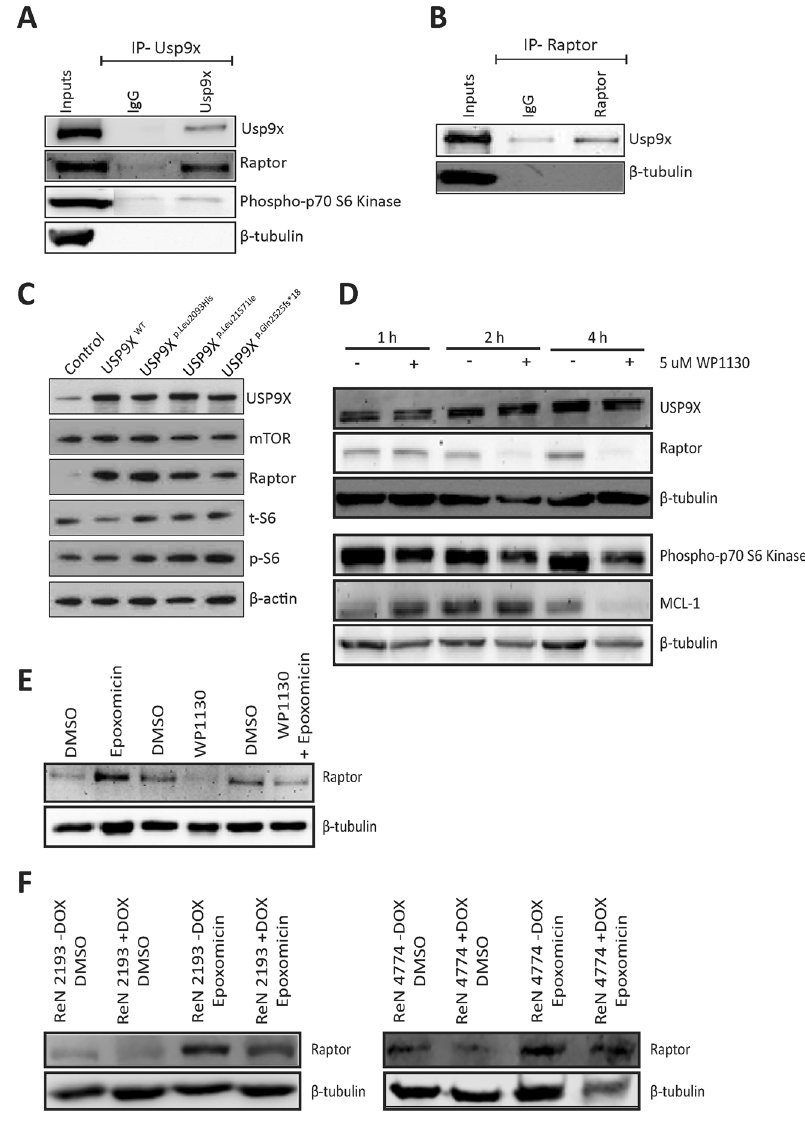
Figure 4. USP9X regulates RAPTOR levels and opposes its proteasomal degradation in neural progenitors. ( A , B ) Co-immunoprecipitation of endogenous Usp9x and Raptor from E14.5 mouse frontal cortex. ( A ) Anti- Usp9x antibodies precipitated Raptor protein. An interaction with pp70S6 kinase was also detected. ( B ) Anti- Raptor antibodies precipitated Usp9x protein. ( C ) USP9X over-expression increased RAPTOR protein levels. Proliferating HEK293T cells were transiently transfected with empty vector, full length USP9X (WT) or one of three USP9X variants, which do not affect enzymatic activity but are associated with human intellectual disability. Cell lysates were collected 24 hours later. Immunoblot analysis identified increased RAPTOR protein but mTOR and total S6 levels were unaffected. ( D ) Chemical inhibition of USP9X deubiquitylating activity leads to a rapid depletion of RAPTOR protein in neural progenitors. ReNcell VM cells were treated with 5 μ M WP1130 and analysed by immunoblot. WP1130 does not deplete USP9X protein levels over 4 hours but results in almost complete loss of RAPTOR by 2 hours. pp70S6 kinase levels were not affected. Levels of another USP9X substrate MCL1 were depleted after 4 hours. ( E ) RAPTOR protein levels are regulated by proteasomal inhibition (epoxomicin) and inactivation of USP9X deubiquiytlating activity (WP1130) in ReNcell VM cells. Proteasomal inhibition following 4 hours exposure to 25 nM epoxomicin resulted in increased RAPTOR levels. Inhibition of USP9X DUB activity with 5 μ M WP1130 for 4 hours resulted in decreased RAPTOR. Treatment of wild- type ReNcell VM cells for 4 hours with WP1130 followed by 4 hours of epoxomicin resulted in intermediate levels of RAPTOR. DMSO was used as the vehicle control for each experiment. Final concentrations of DMSO were – 0.0025% for epoxomicin; 0.00005% for WP1130; 0.00255% for WP1130 + Epoxomicin. ( F ) Epoxomicin treatment of 2193 and 4774 ReNcell VM cells resulted in increased RAPTOR protein levels. The addition of doxycycline ( + DOX) resulted in intermediate levels of RAPTOR. Representative of two biological